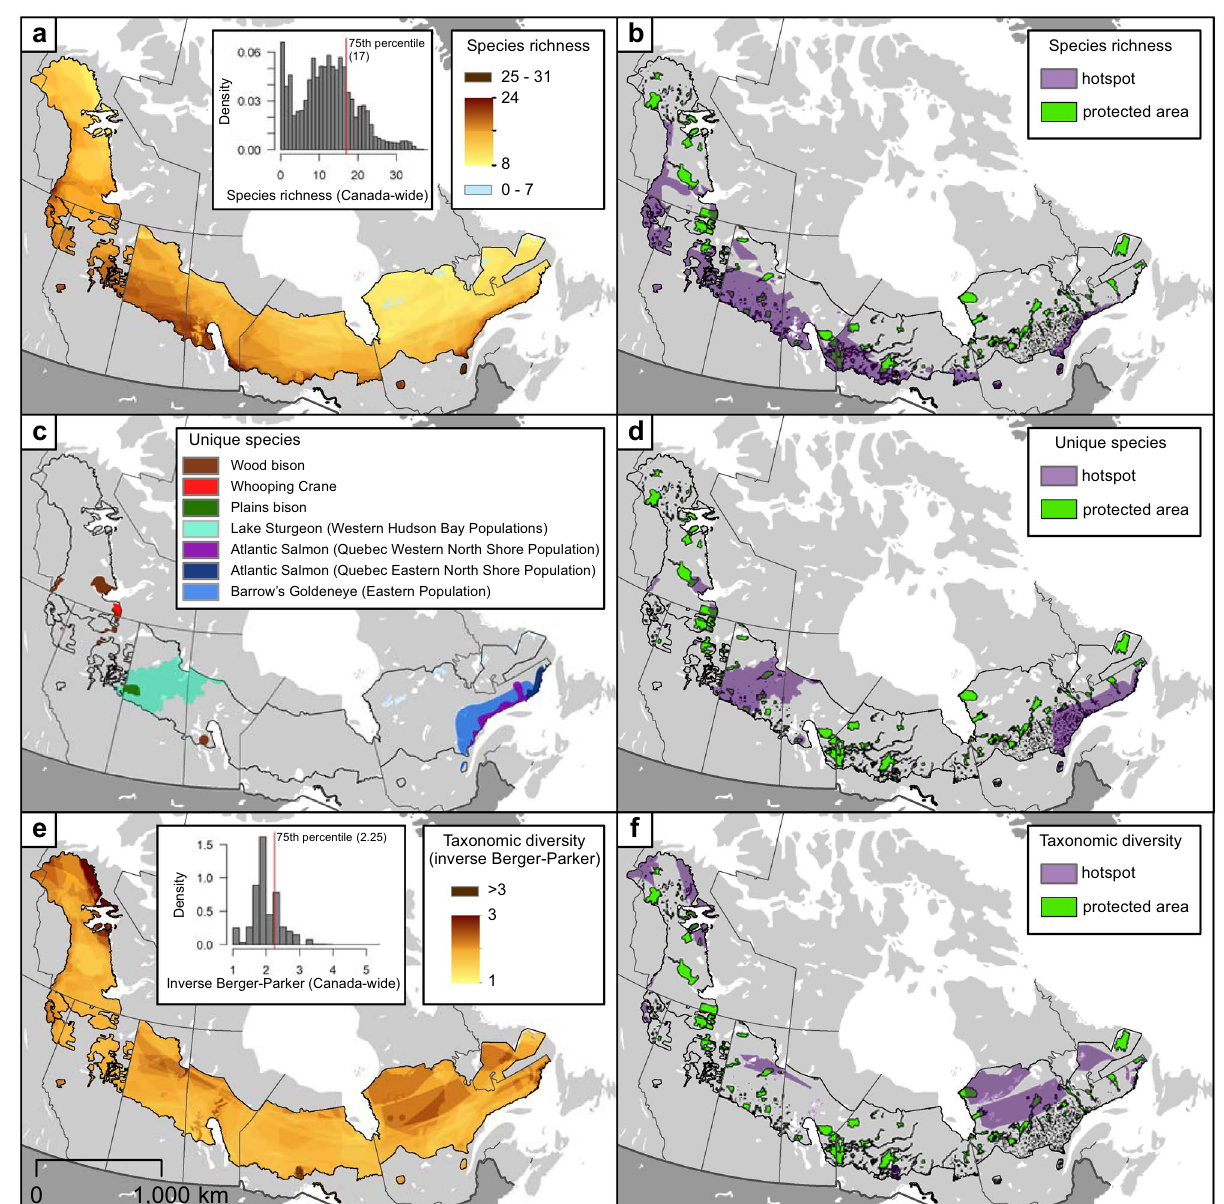
Figure 2. Distribution of raw values (left column) and hotspots (right column) for ( a – b ) species richness; ( c – d ) unique species; and ( e – f ) taxonomic diversity across the distribution of boreal caribou. Species richness and taxonomic diversity hotspots identified using top quantiles. Unique species hotspots identified as any area occupied by one of the seven species classified as unique within the boreal caribou